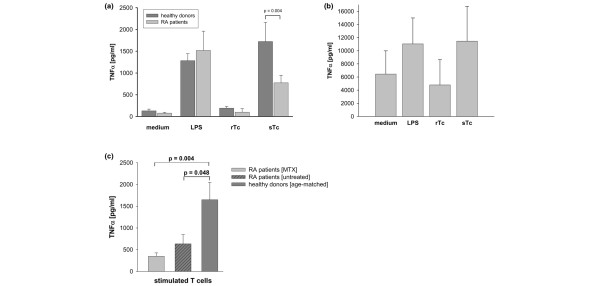
Decreased T cell induced production of TNF-α in monocytes from RA patients. (a) T cell-induced tumour necrosis factor (TNF)-α secretion by monocytes from patients with rheumatoid arthritis (RA) is decreased in comparison with those from healthy controls. Peripheral-blood T cells (106/ml) were cultured for 48 hours in the presence or absence of immobilized anti-CD3 (3.3 μg/ml) and soluble anti-CD28 (0.8 μg/ml) antibodies. Stimulated (sTc) and resting (rTc) T cells were fixed and incubated with freshly isolated monocytes (1.5 × 106/ml) at a ratio of 7:1. After 24 hours, the concentration of TNF-α was measured in the supernatant. Lipopolysaccharide (LPS; 100 ng/dl) was used as a positive control. Data are means ± SEM of values from 20 patients with RA and 20 age-matched controls. (b) Macrophages separated from the synovial membrane of patients with RA produce large amounts of TNF-α after contact with preactivated T cells. Stimulated (sTc) and resting (rTc) T cells were fixed and incubated with freshly isolated synovial macrophages from patients with RA (1.5 × 106/ml) at a ratio of 7:1. After 24 hours, the concentration of TNF-α was measured in the supernatant. LPS (100 ng/ml) was used as a positive control. Data are means ± SEM of values from six independent experiments. Level of significance: not significant. (c) Decrease in T cell-induced TNF-α secretion by monocytes from patients with RA is independent of previous and current treatments. The graph depicts the T cell-induced TNF-α production by monocytes of patients with RA either receiving methotrexate (MTX; n = 5) or not receiving immunosuppressive treatment (untreated; n = 6). For comparison, results for six age-matched controls are given (P < 0.05, significant difference compared with untreated patients).